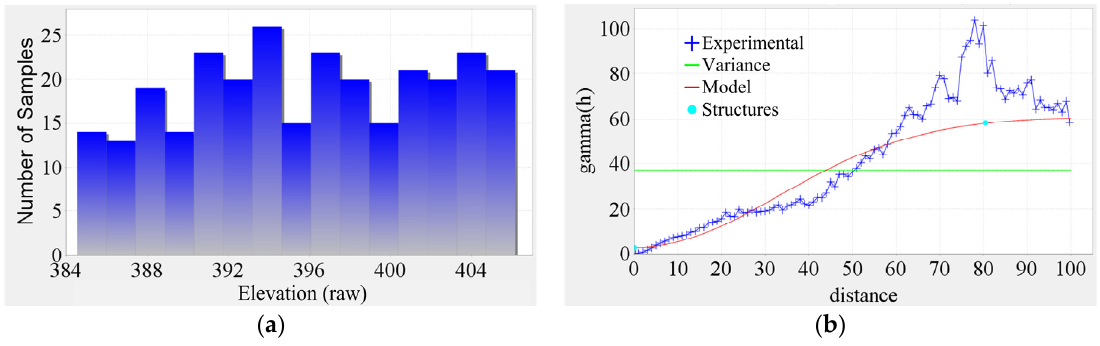
Figure 7. Locations of 39 drillholes on Mathiatis area DTM in 3D preview.